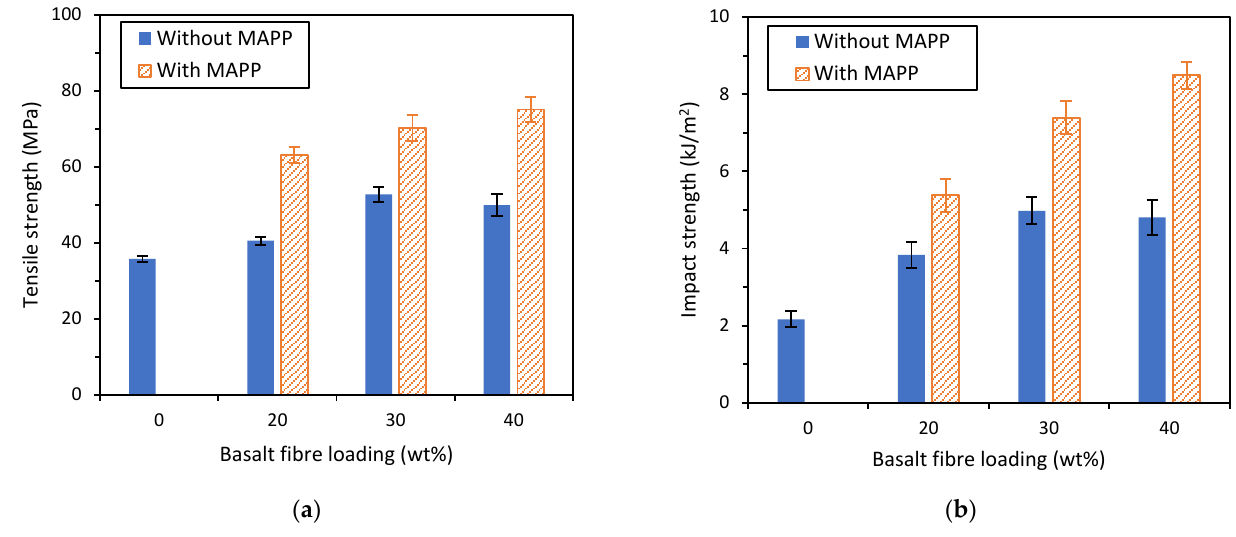
Figure 8. ( a ) Tensile strength and ( b ) impact strength of short BF-PP composites with and without the use of MAPP as compatibiliser. Table 6. Tensile and impact properties of the short BF- PP composites.